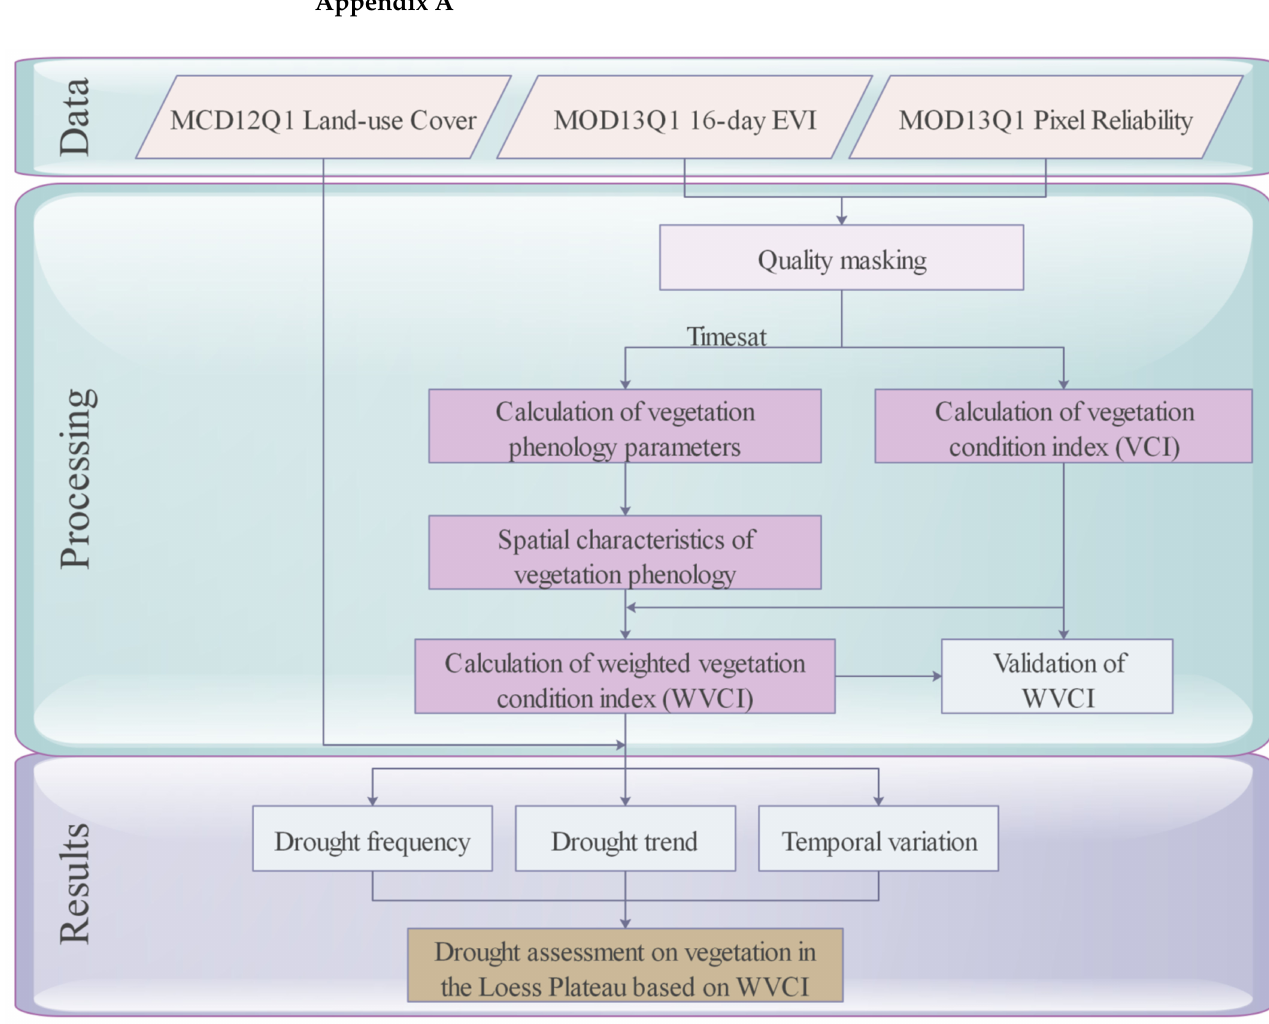
Figure A1. Overview of the workflow in this study.